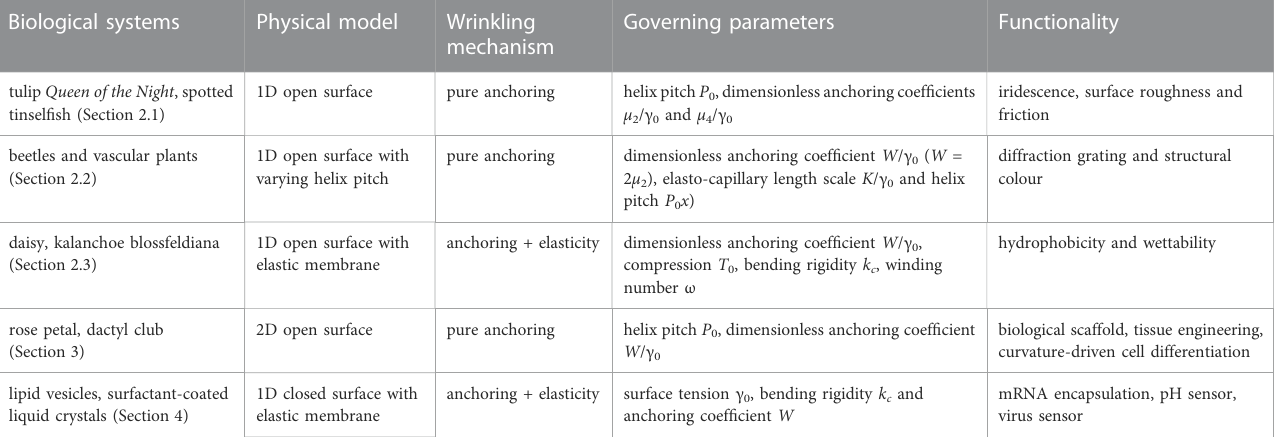
TABLE 1 Summary of surface wrinkling morphology observed in experiment and theoretical simulation.